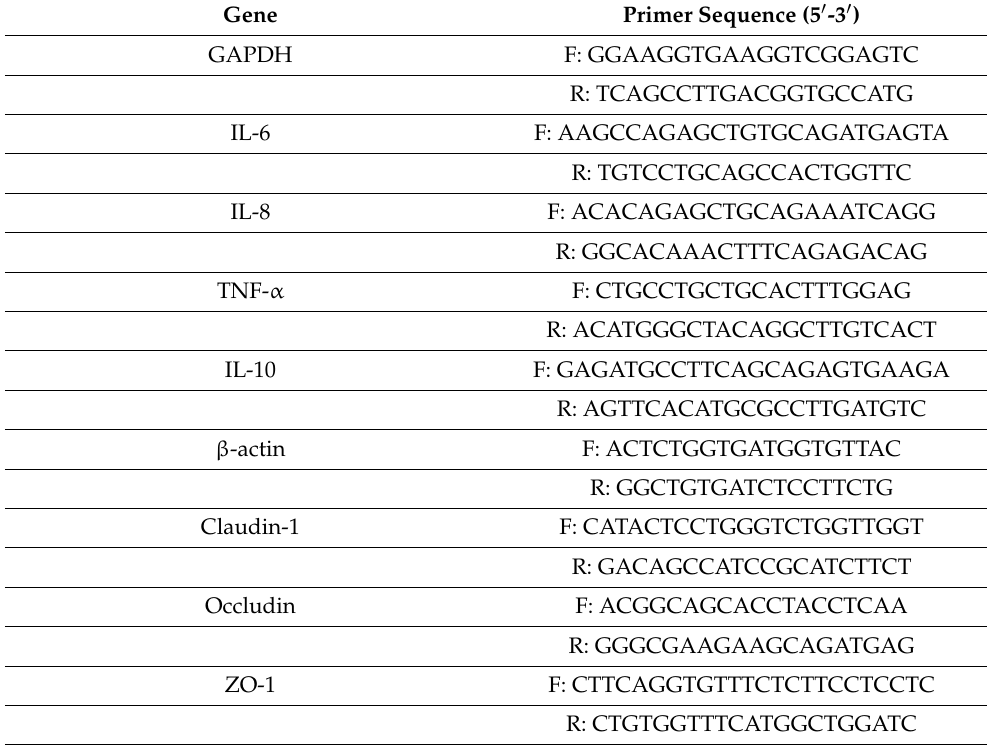
Table 1. Primers used in real-time quantitative